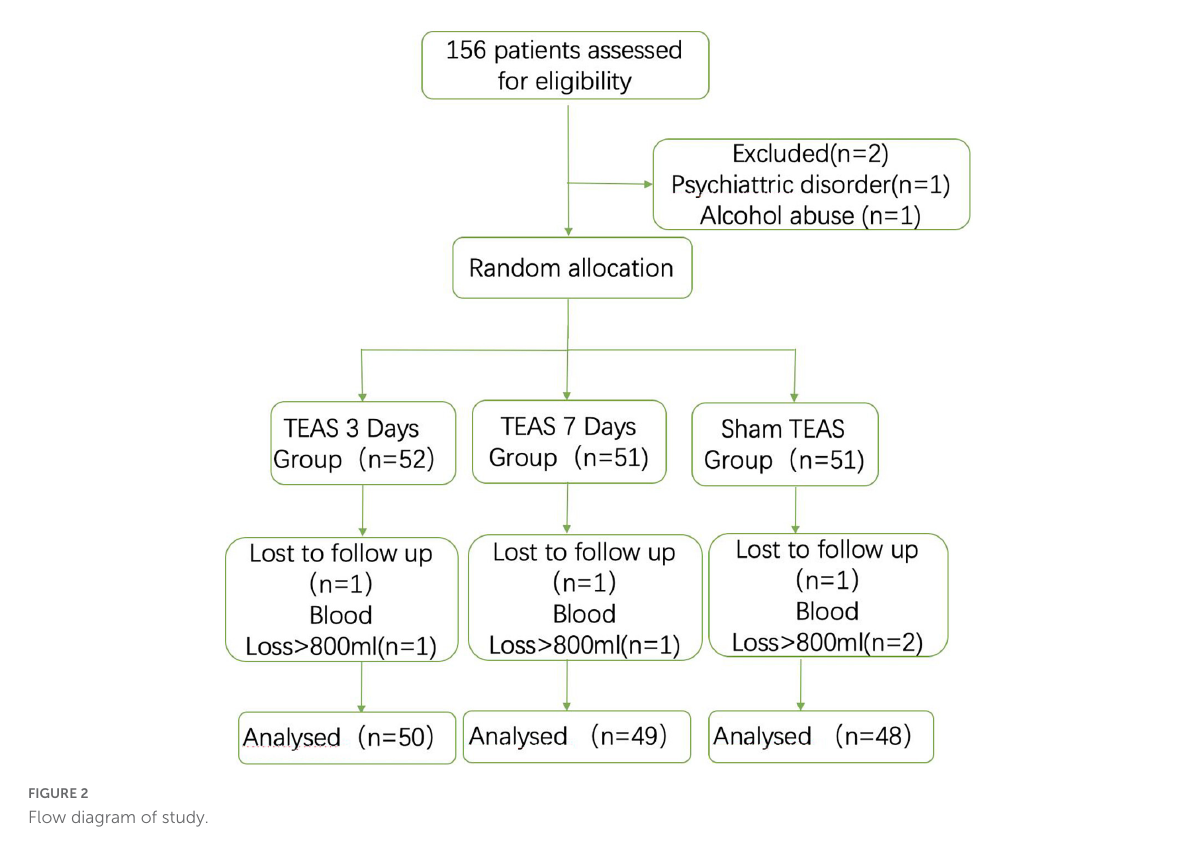
FIGURE2 Flow diagram of study.